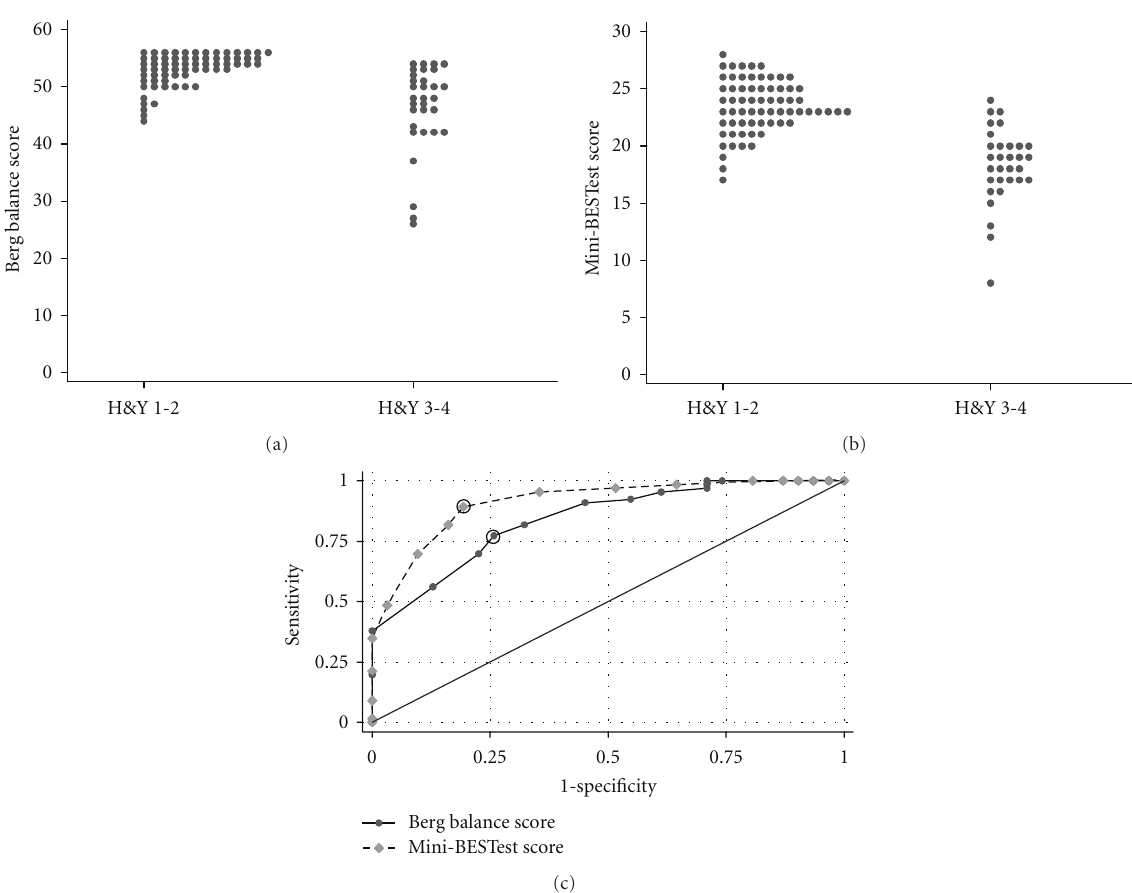
Figure 3: (a) and (b) show the distribution of scores on the Berg Balance Scale (a) and the Mini-BESTest (b) when patients were separated into those without postural response deficits (H&Y 1-2) and those with postural deficits (H&Y 3-4). (c) compares the receiver operator characteristics of the Berg Balance Scale and the Mini-BESTest to di ff erentiate people with and without postural response deficits as measures by H&Y